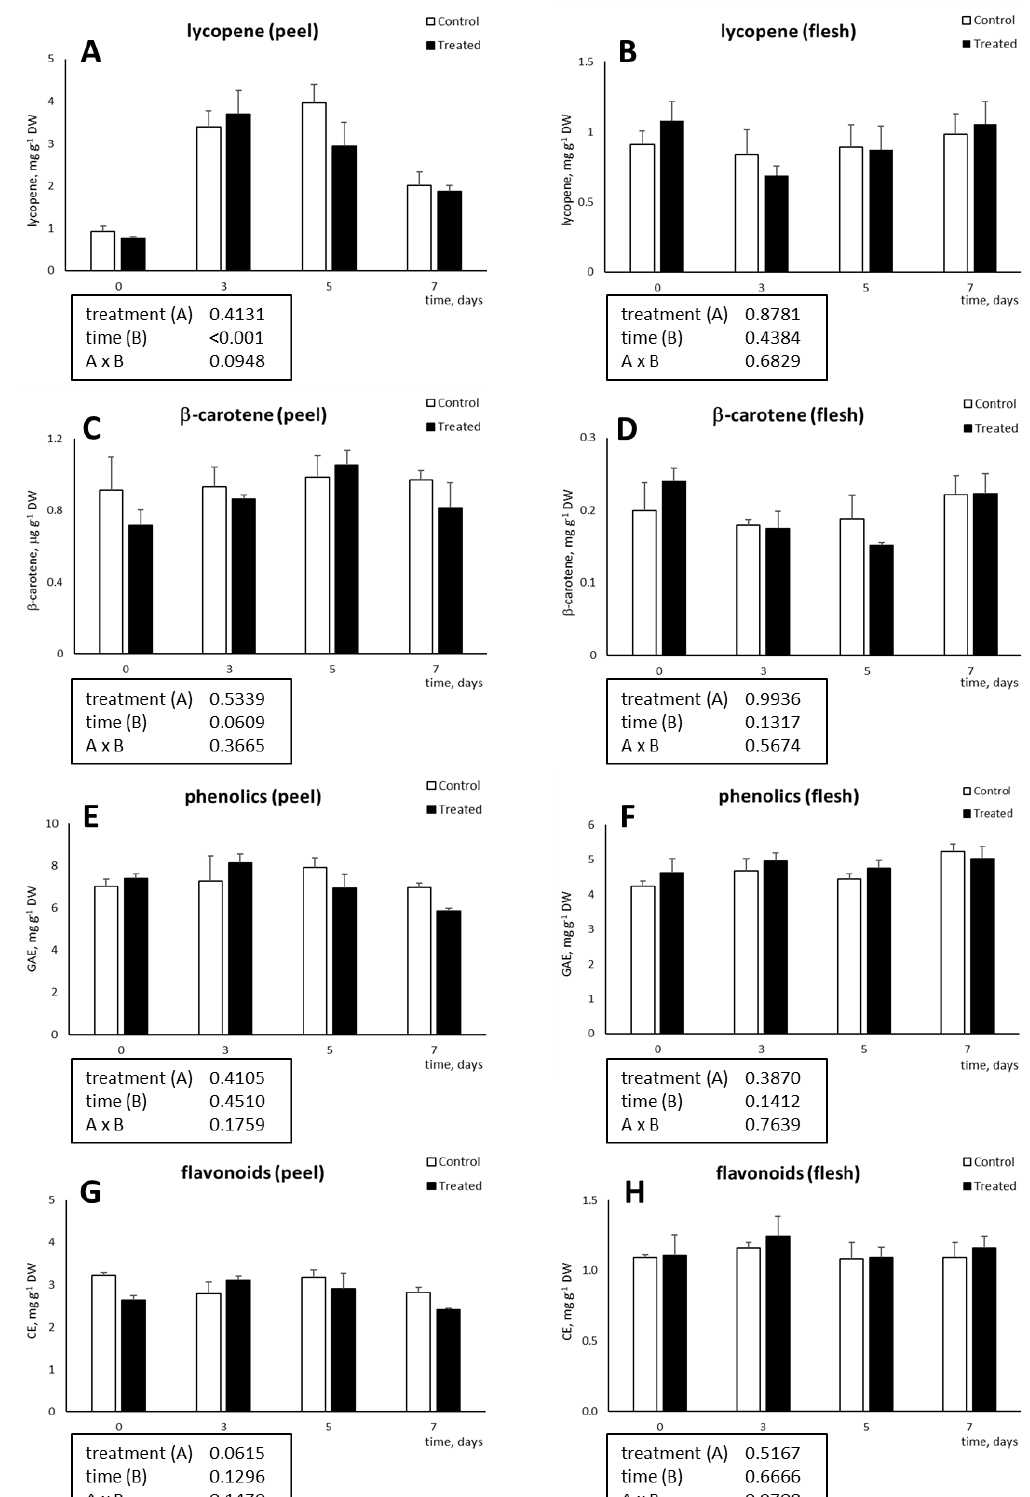
Figure 3. Concentration (mg g − 1 DW) of lycopene ( A , B ) and β -carotene ( C , D ) and concentration (mg g − 1 DW) of total phenolics ( E , F ) and flavonoids ( G , H ) in peel ( A – G ) and flesh ( B – H ) of tomato fruit coated with tyrosol-enriched chitosan solution or left uncoated (control) for up to 7 days. The results of two-way ANOVA ( p < 0.05) are reported in the